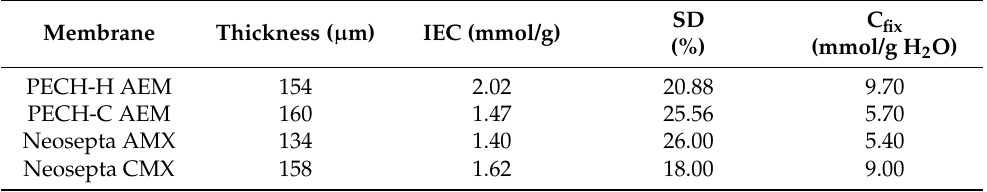
Table 1. Properties of custom-made and commercial membranes (custom-made PECH membranes: BR = 0.6 and EDR =